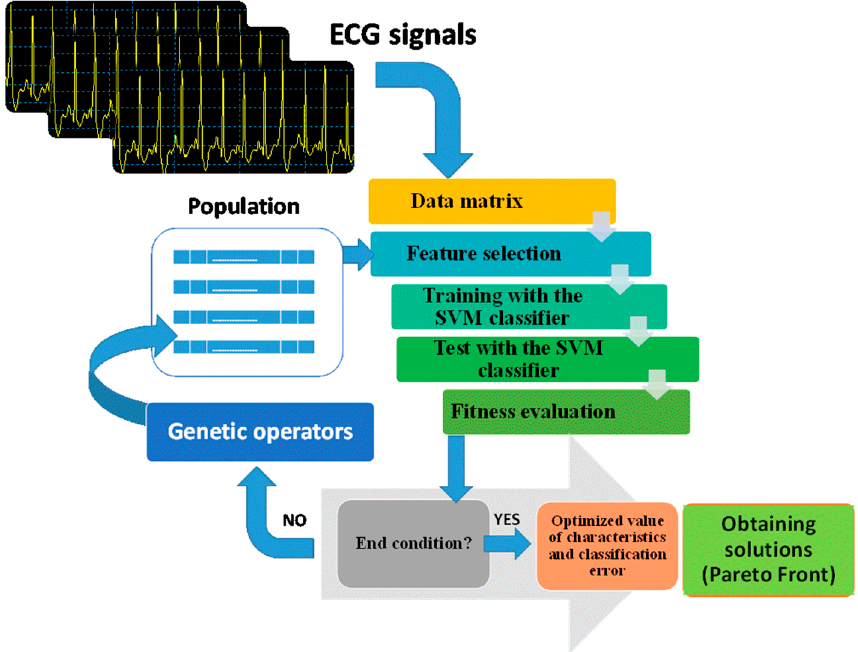
Figure 2. Block diagram of the Multi-objective Genetic Algorithm for the determination of relevant characteristics together with the parameters used.